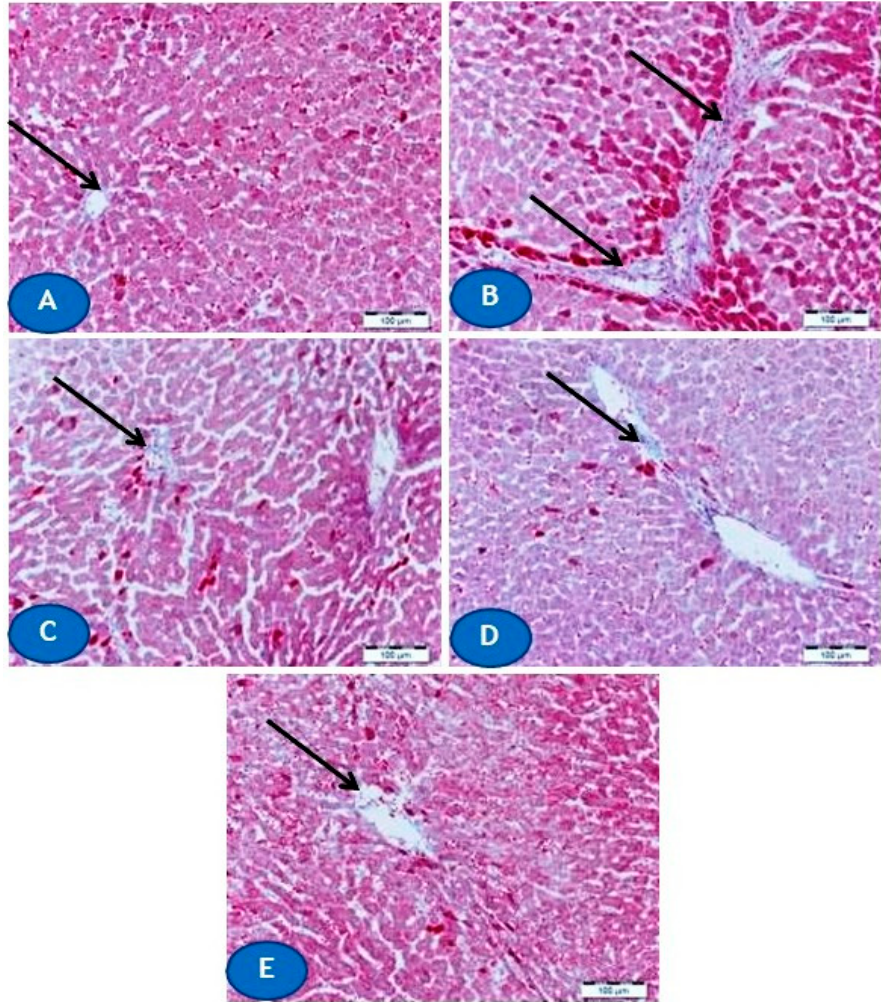
Figure 3. Photomicrographs of Masson’s trichrome (MT)-stained sections from liver of ( A ) control rats showing normal amount and distribution of collagen fibers around blood vessels (arrow), ( B ) Pb(II)-intoxicated rats showing an increase in collagen deposition (arrows), and ( C – E ) Pb(II)-administered rats treated with CUR ( C ) and AA ( D ) showing marked decrease in collagen deposition (arrow), and CUR / AA ( E ) showing apparently normal distribution of collagen fibers (arrow). (X400, Scale bare 50 µ m).